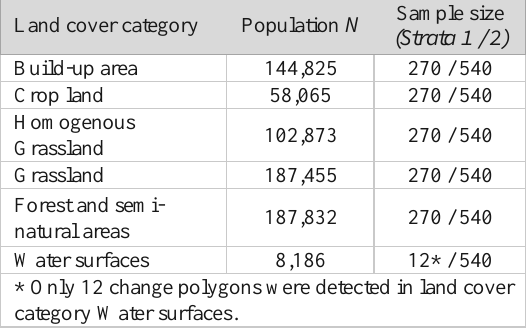
Table 2 . Sample size n for strata 1 and 2.